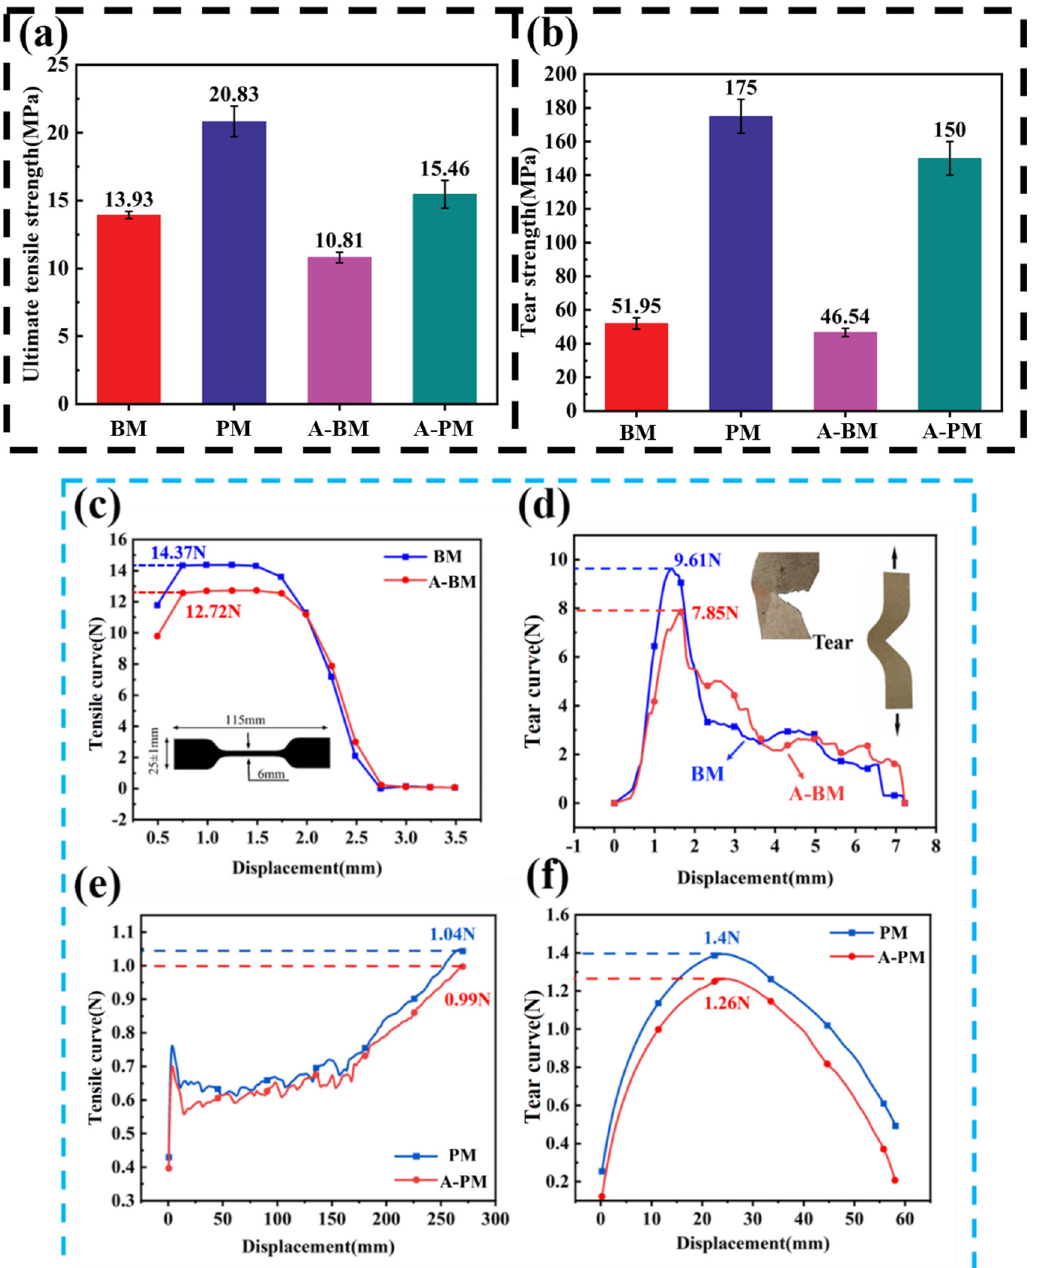
Figure 6. ( a ) Tensile strength of BM paper film and PM white film before and after dry heat aging; ( b ) tear strength of BM and PM before and after dry heat aging; ( c ) tensile curve of BM paper film before and after aging; ( d ) tear curve of BM paper film before and after aging; ( e ) tensile curve of PM white film before and after aging; ( f ) tear curve of PM white film before and after aging.